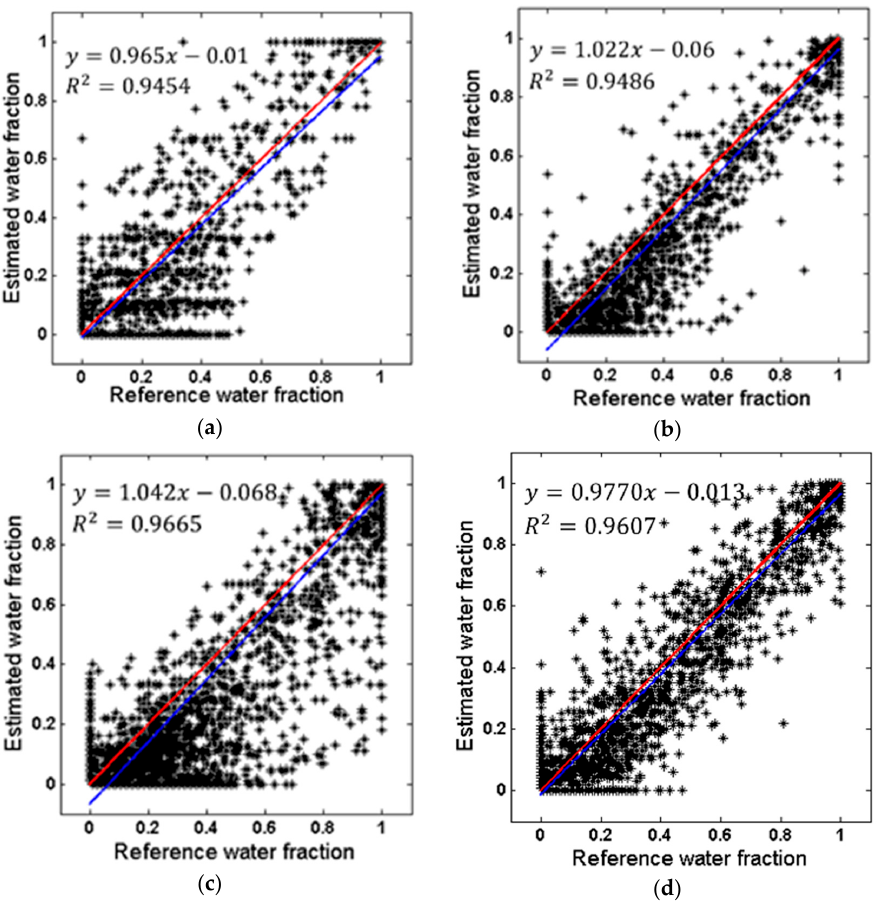
Figure 7. Comparison between the reference and estimated water fractions obtained by ASWM, where the red line is the 1:1 reference line, and the blue line is the regression line. ( a – d ) represent the results for the study areas of Beijing, Shanghai, Hangzhou, and Guangzhou, respectively.